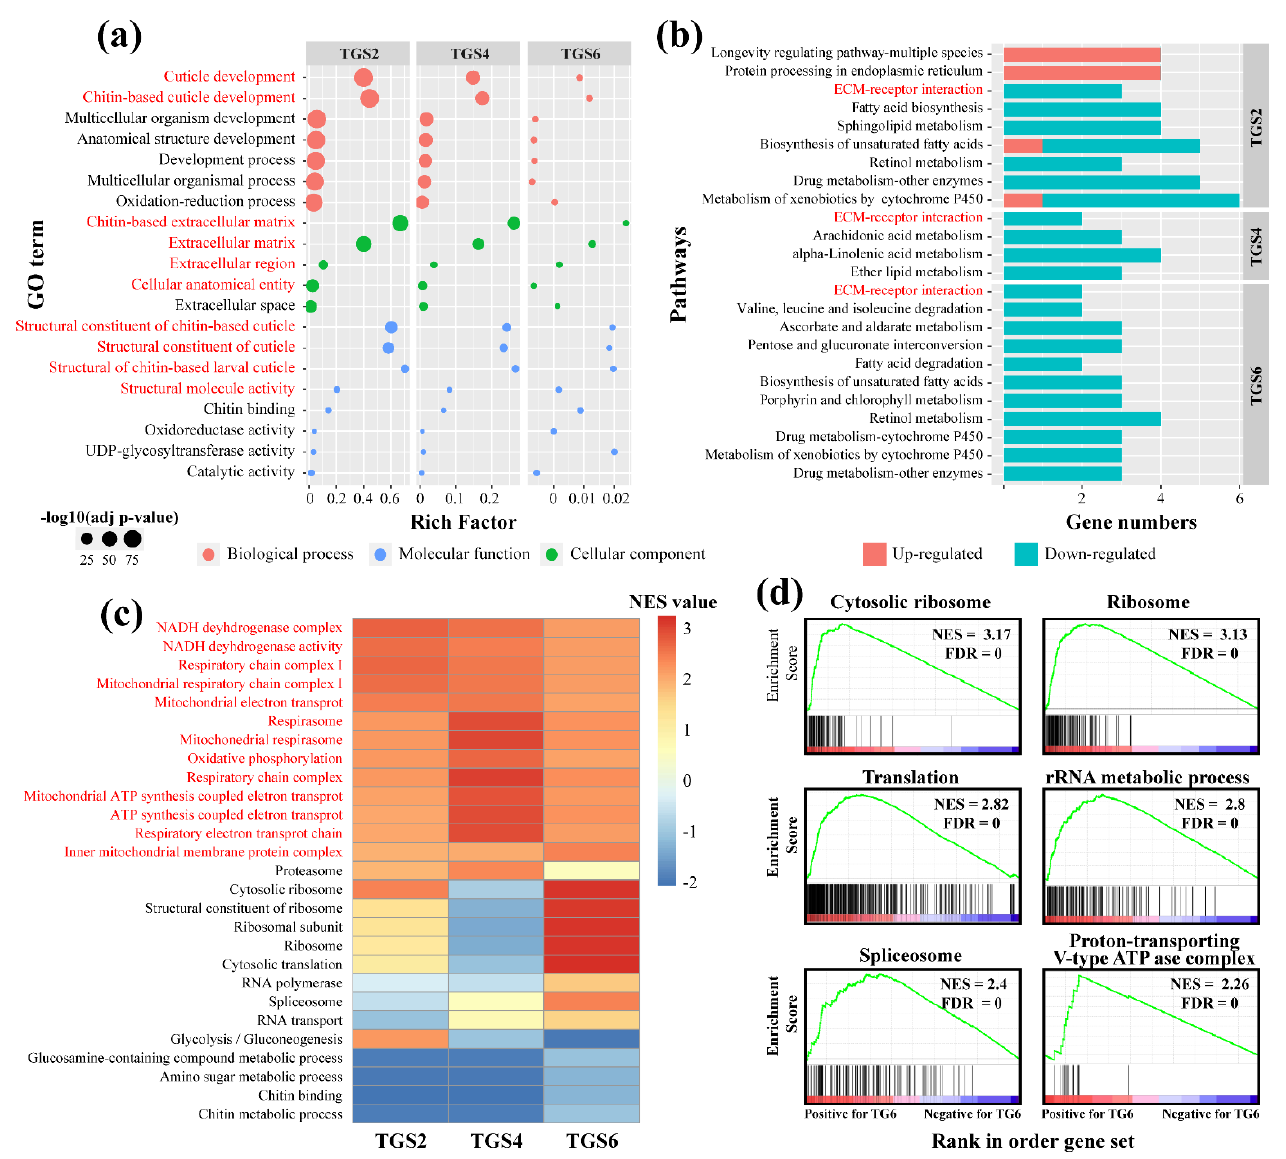
Figure 3. Functional enrichment analysis for TGS2, TGS4, and TGS6. ( a ) GO and ( b ) KEGG pathway enrichment for TGS2, TGS4, and TGS6 groups. All GO terms were enriched by downregulated genes. GO terms or pathways shared among TGS2, TGS4, and TGS6 groups are indicated by the red font. ( c ) Heatmap for GSEA analysis. The normalized enrichment score (NES) was used as input. Gene sets enriched in three comparing groups are indicated by the red font. ( d ) GSEA analyses of gene sets for TGS6. NES, normalized enrichment score. FDR, false discovery rate. The top portion of the plot shows the running ES for the gene set as the analysis walks down the ranked list. The bottom portion of the plot shows where the members of the gene set appear in the ranked list of genes. Positive (red) and negative (blue) NES indicate higher and lower expression in TGS samples, respectively.